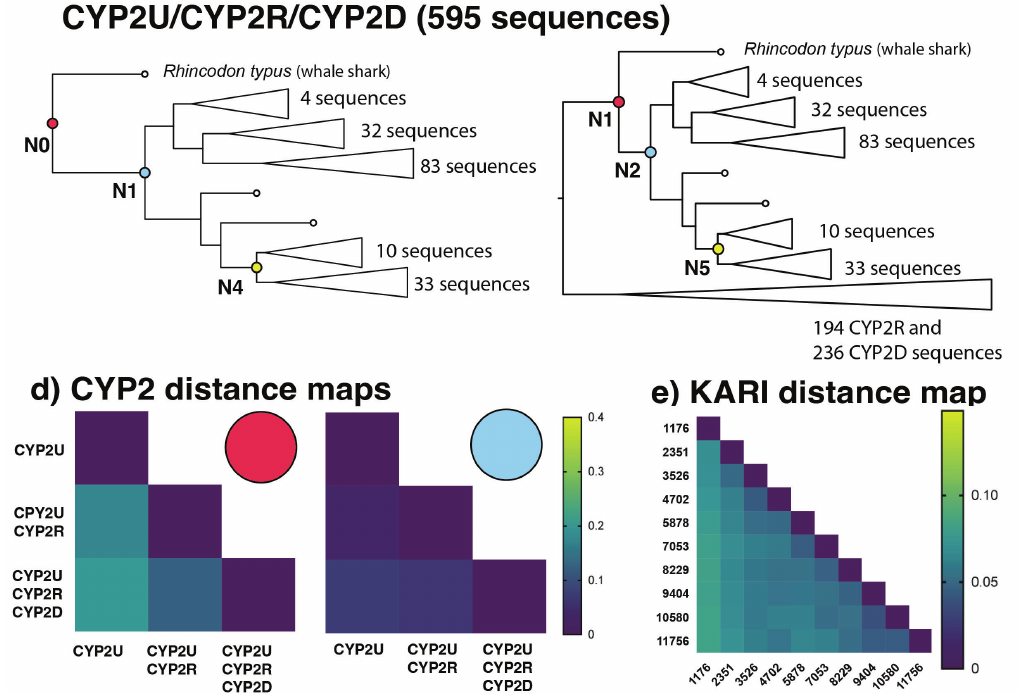
Fig 4. A, Phylogenetic trees of the smallest and largest DHAD data sets after producing 14 randomly sampled data sets in 500 sequence increments, added to our base data set of 1,612 sequences and reaching a maximum size of 9,112 sequences. B , Heat maps of the fractional distances between ancestor sequences generated from different DHAD data set sizes, representing the same (principal) three branch points. C , Phylogenetic trees of the smallest and largest data sets after increasing CYP2U sequences via addition of homologous subfamilies, starting with 165 CYP2U sequences then growing to 359 sequences and reaching a maximum of 595 sequences via addition of sequences from CYP2R and CYP2D, respectively. D , Heat maps of